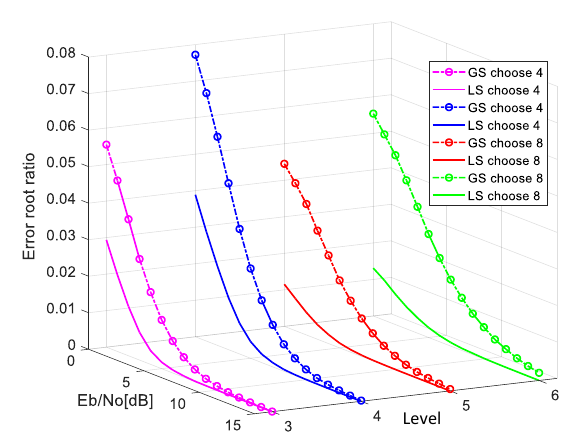
Figure 5. The ratio between sorting error rate with r two sorting models: the local sorting that takes the 4 ( 8 ) best nodes and the all-inclusive sorting that takes the 4 ( 8 ) best nodes at levels 3 , 4 ( 5 , 6 ),